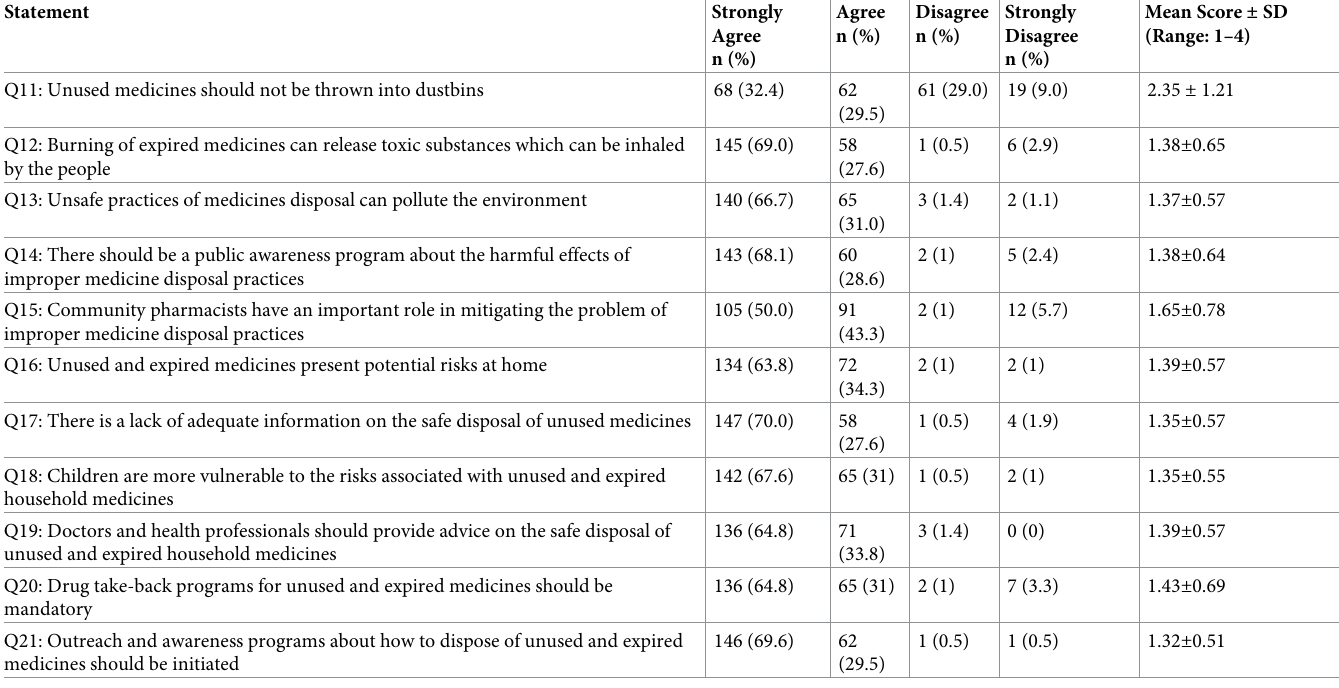
Table 4. Distribution and summary statistics for the attitude questions.